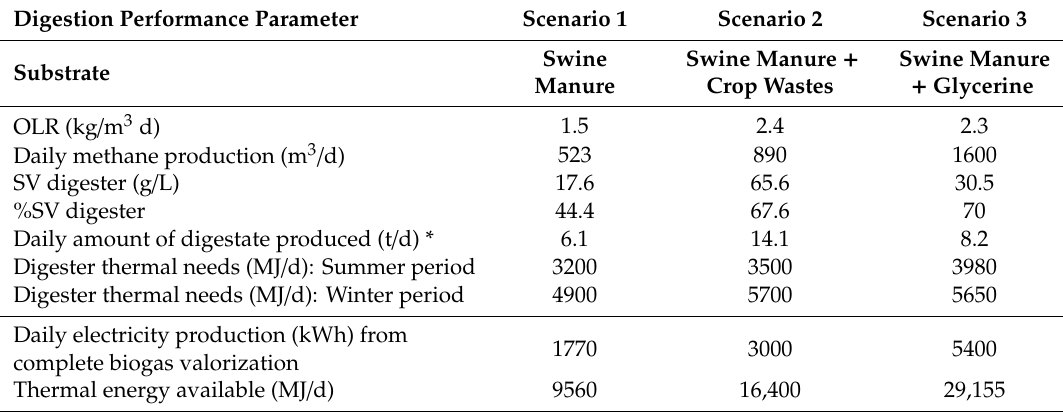
Table 2. Performance of the reactor expected for the di ff erent incoming